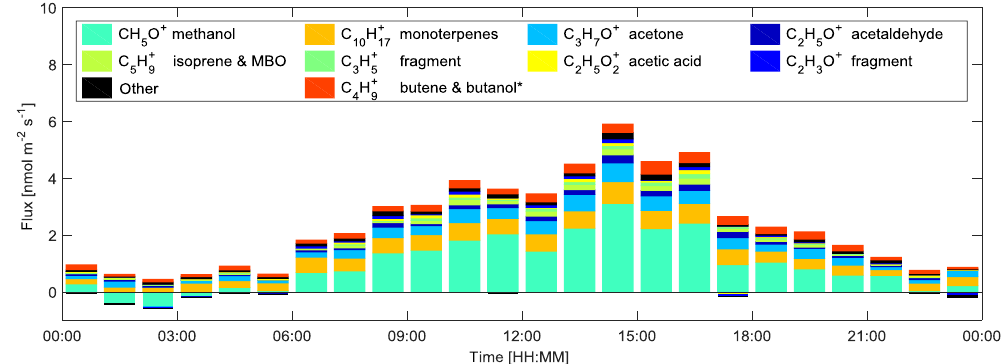
Figure 6. Diurnal variation of the nine most emitted compounds during the 21 days of measurement in June. The remaining compounds are summed up as “other”. The high variation in the flux seen in Fig. 4 (diurnal plot of 9 days of measurements in June) is reduced, as meteorological events (e.g., rain) have less impact on the result. ∗ The butene + butanol exchange is anthropogenic and thereby not emitted by the forest (Sect. 3.4).